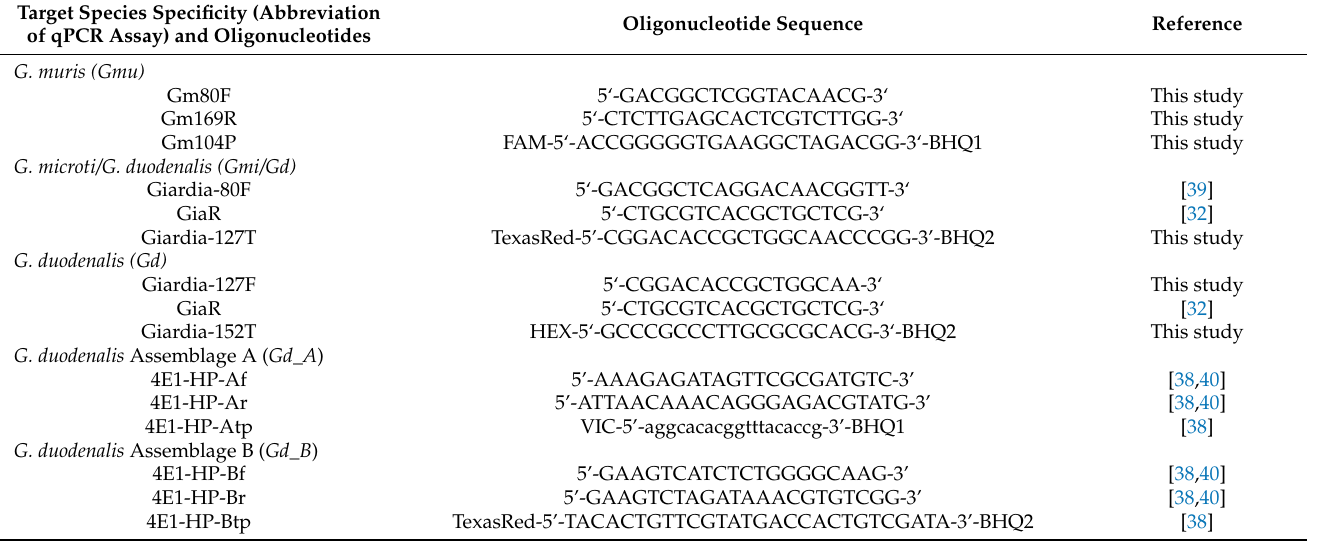
Table 1. Primers used in the